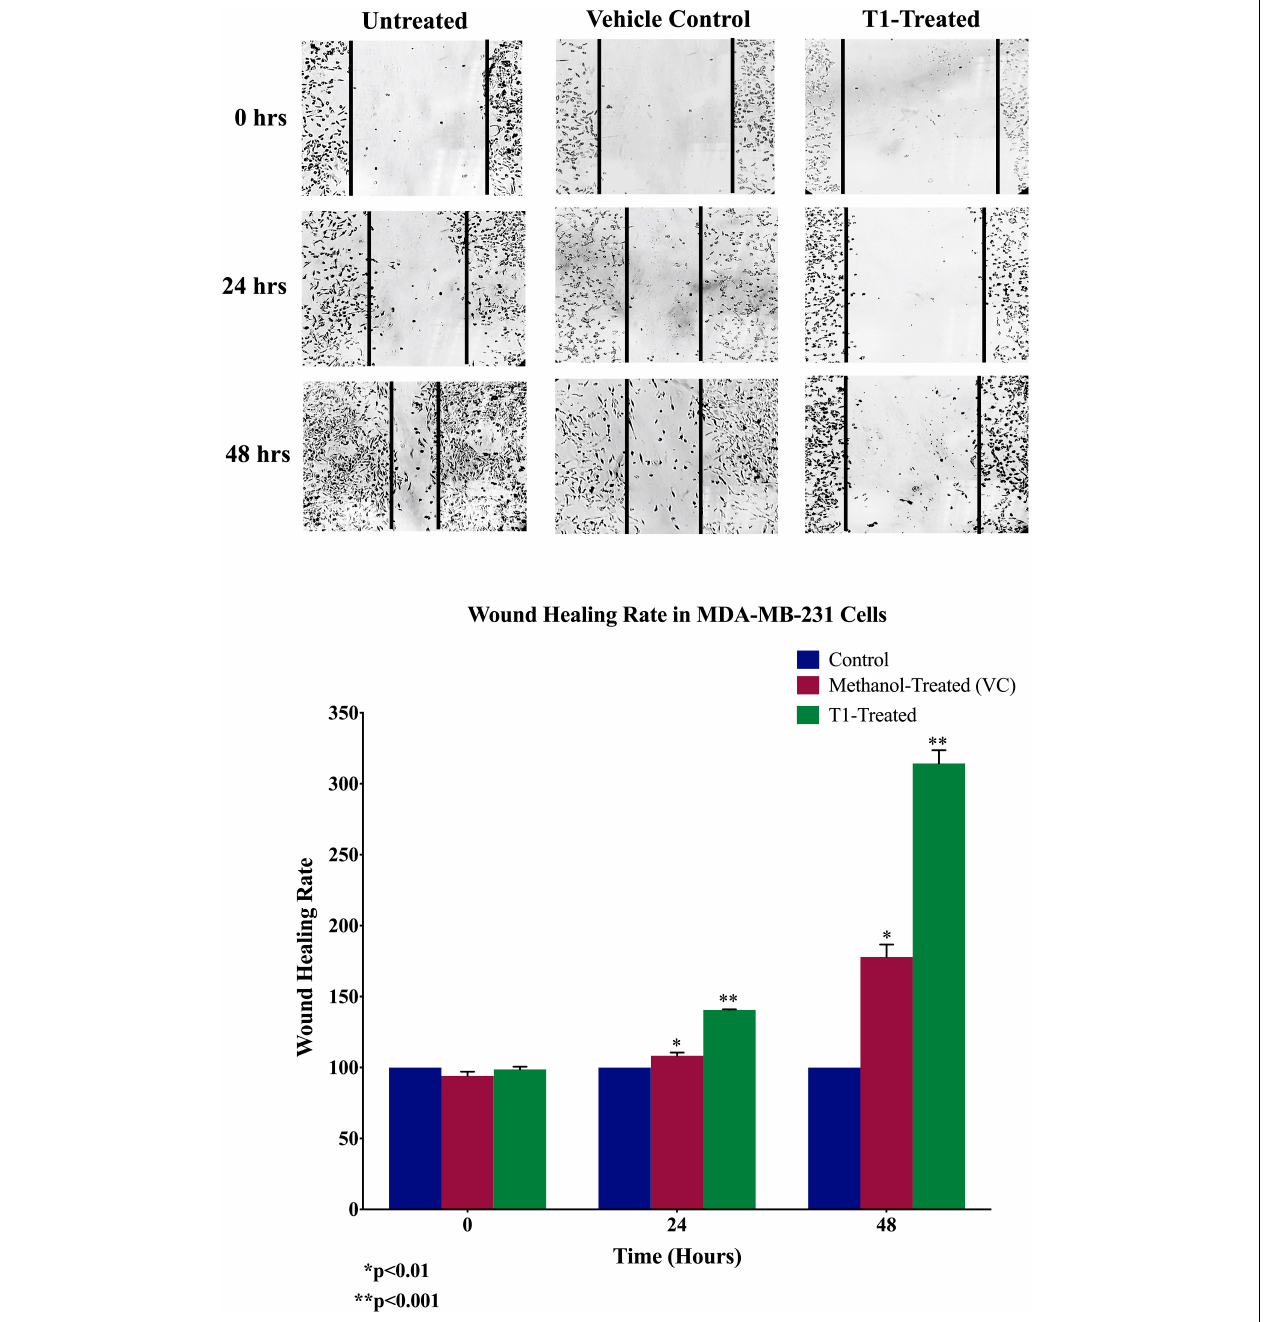
FIGURE 4 | Effect of T1 on migration of MDA-MB-231 using wound healing assay. T1-extract sup-pressed cell motility of MDA-MB-231 cells in comparison to methanol treated (VC: vehicle control) and non-treated cells. Representative images are shown from three independent experiments and dark lines define the areas lacking cells (wound area, ImageJ). Values of percentage wound closure ± SEM ( n = 3). * p < 0.01, ** p <